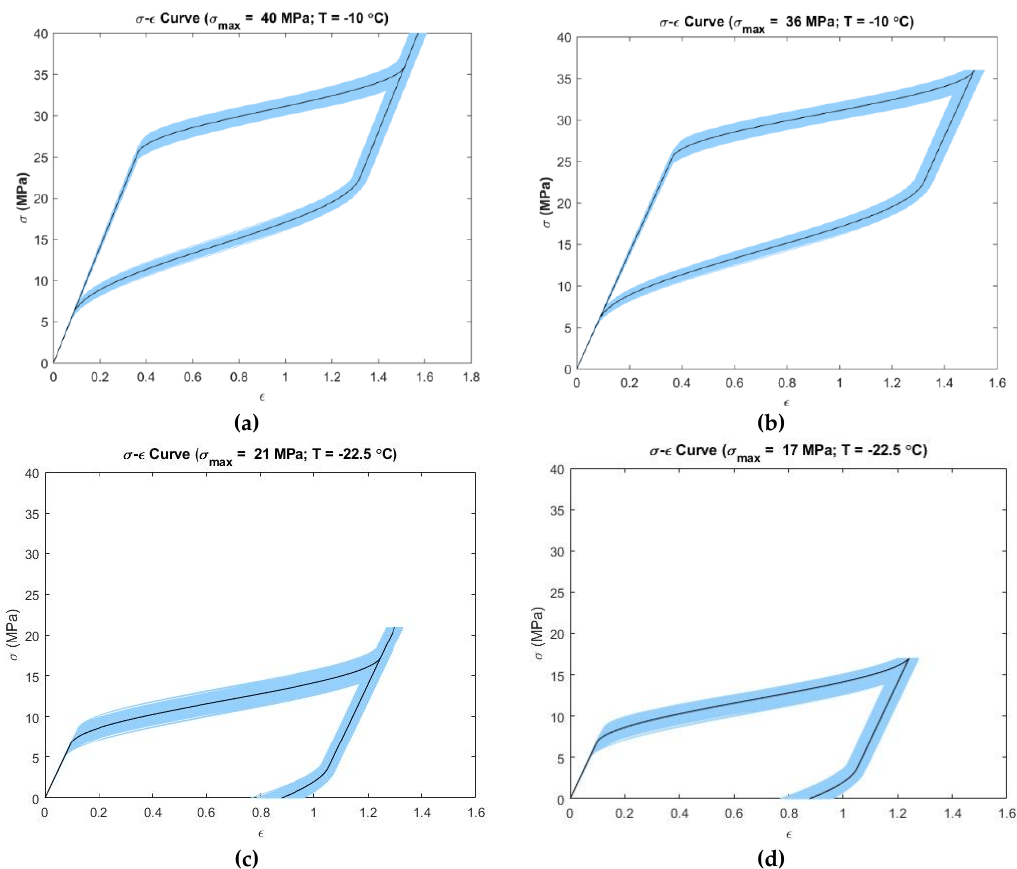
Figure 4. Confidence intervals (5–95 percentile) at simulated temperatures and maximum loading stress for the Liang and Rogers model (the deterministic curve is shown in dark color; the deformation size is shown in the form of strain ( (cid:15) ) on the x-axis): ( a ) T = − 10 ◦ C, σ max = 40 MPa; ( b ) T = − 10 ◦ C, σ max = 36 MPa; ( c ) T = − 22.5 ◦ C, σ max = 21 MPa; ( d ) T = − 22.5 ◦ C, σ max = 17 MPa.